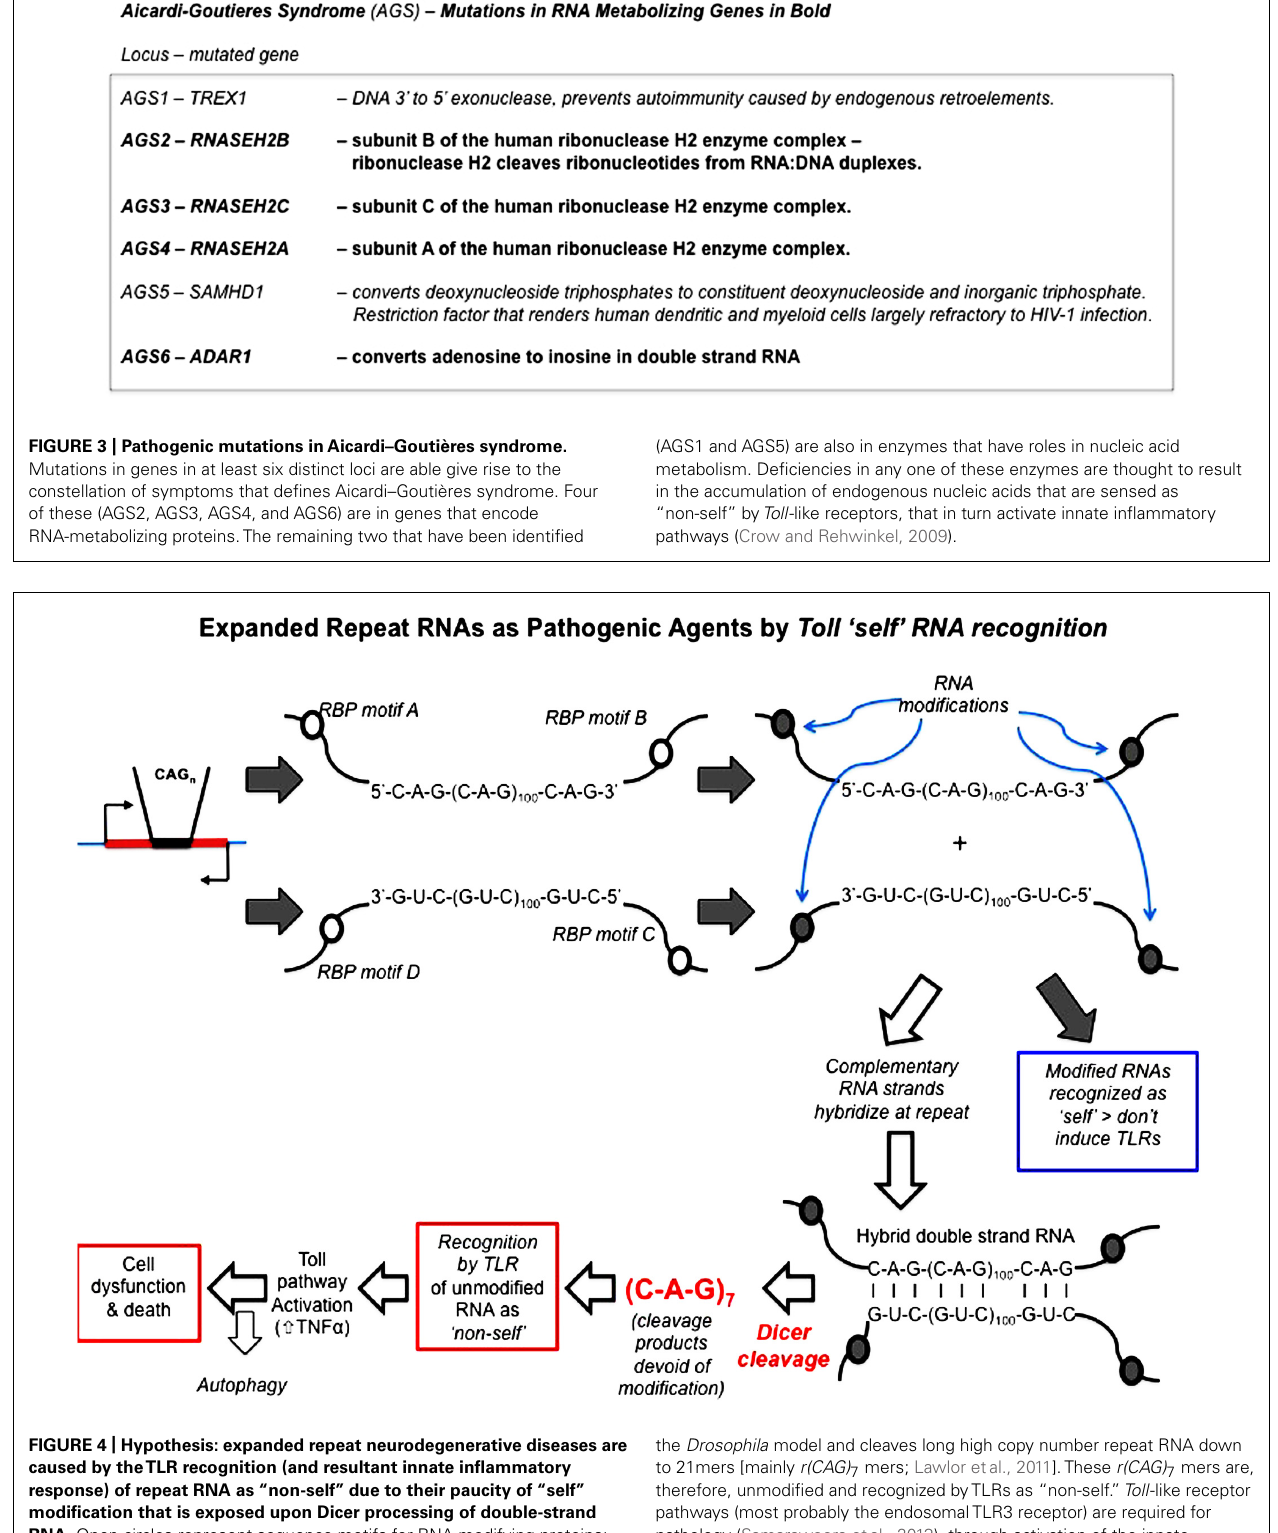
the Drosophila model and cleaves long high copy number repeat RNA down to 21mers [mainly r(CAG) 7 mers; Lawlor etal., 2011].These r(CAG) 7 mers are, therefore, unmodified and recognized byTLRs as “non-self.” Toll -like receptor pathways (most probably the endosomalTLR3 receptor) are required for pathology (Samaraweera etal., 2013), through activation of the innate inflammatory pathway. Autophagy reduces pathology, possibly by metabolizing r(CAG) 7